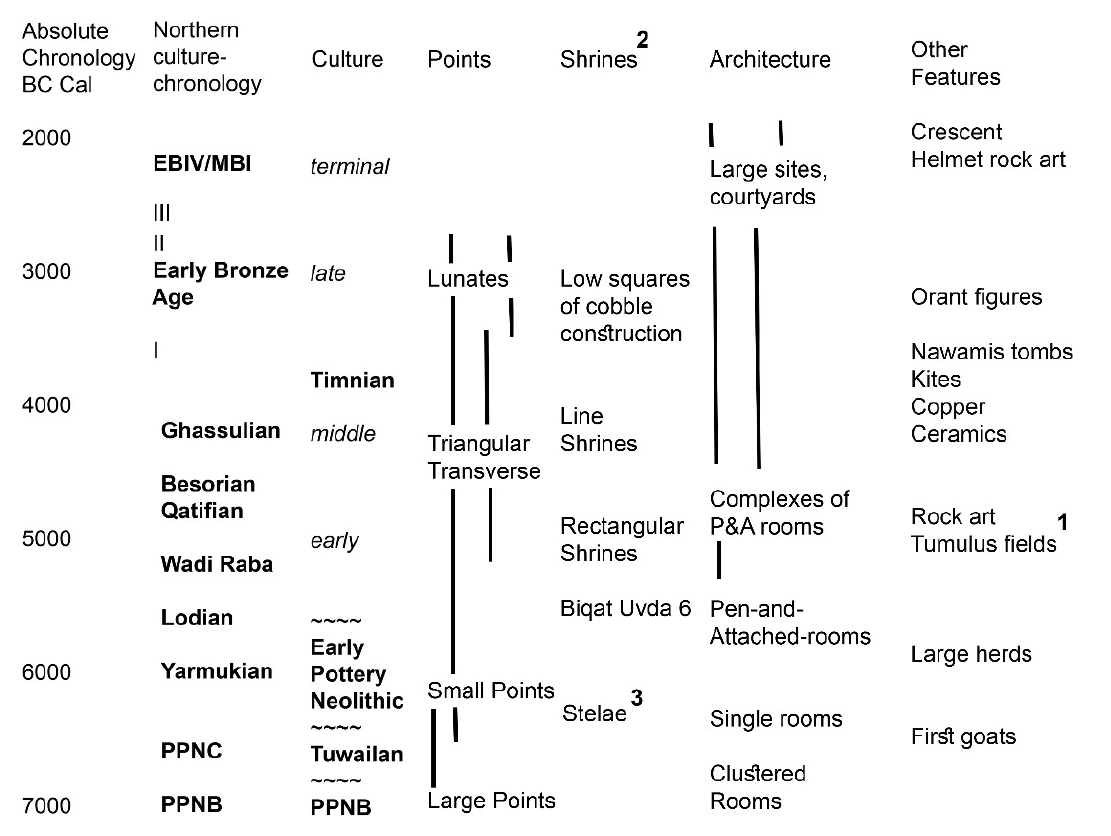
Figure 2 Chronological schematic of region with absolute chronology, comparison of northern and southern sequences, and various features. The following points are to be noted: 1. Although cairn fields begin early in the sequence, they continue in use, and perhaps in construction, throughout the sequence; 2. The shrine sequence is presented as an hypothesis and dates are relative, not absolute, 3. Stelae appear relatively early in the sequence and continue through its